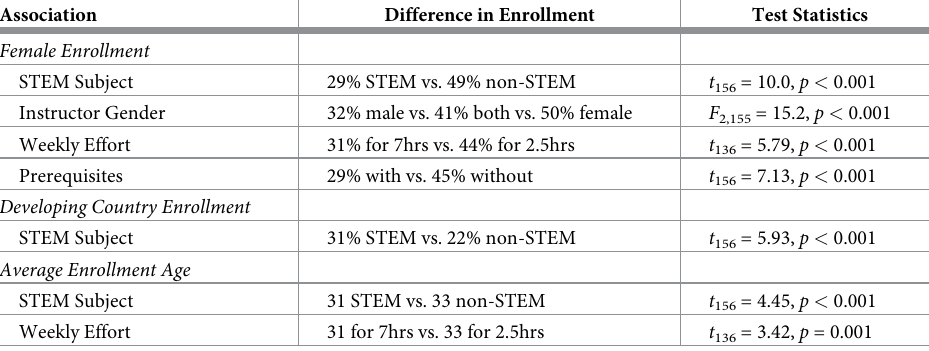
Table 4. Summary of significant associations with enrollment in both samples.